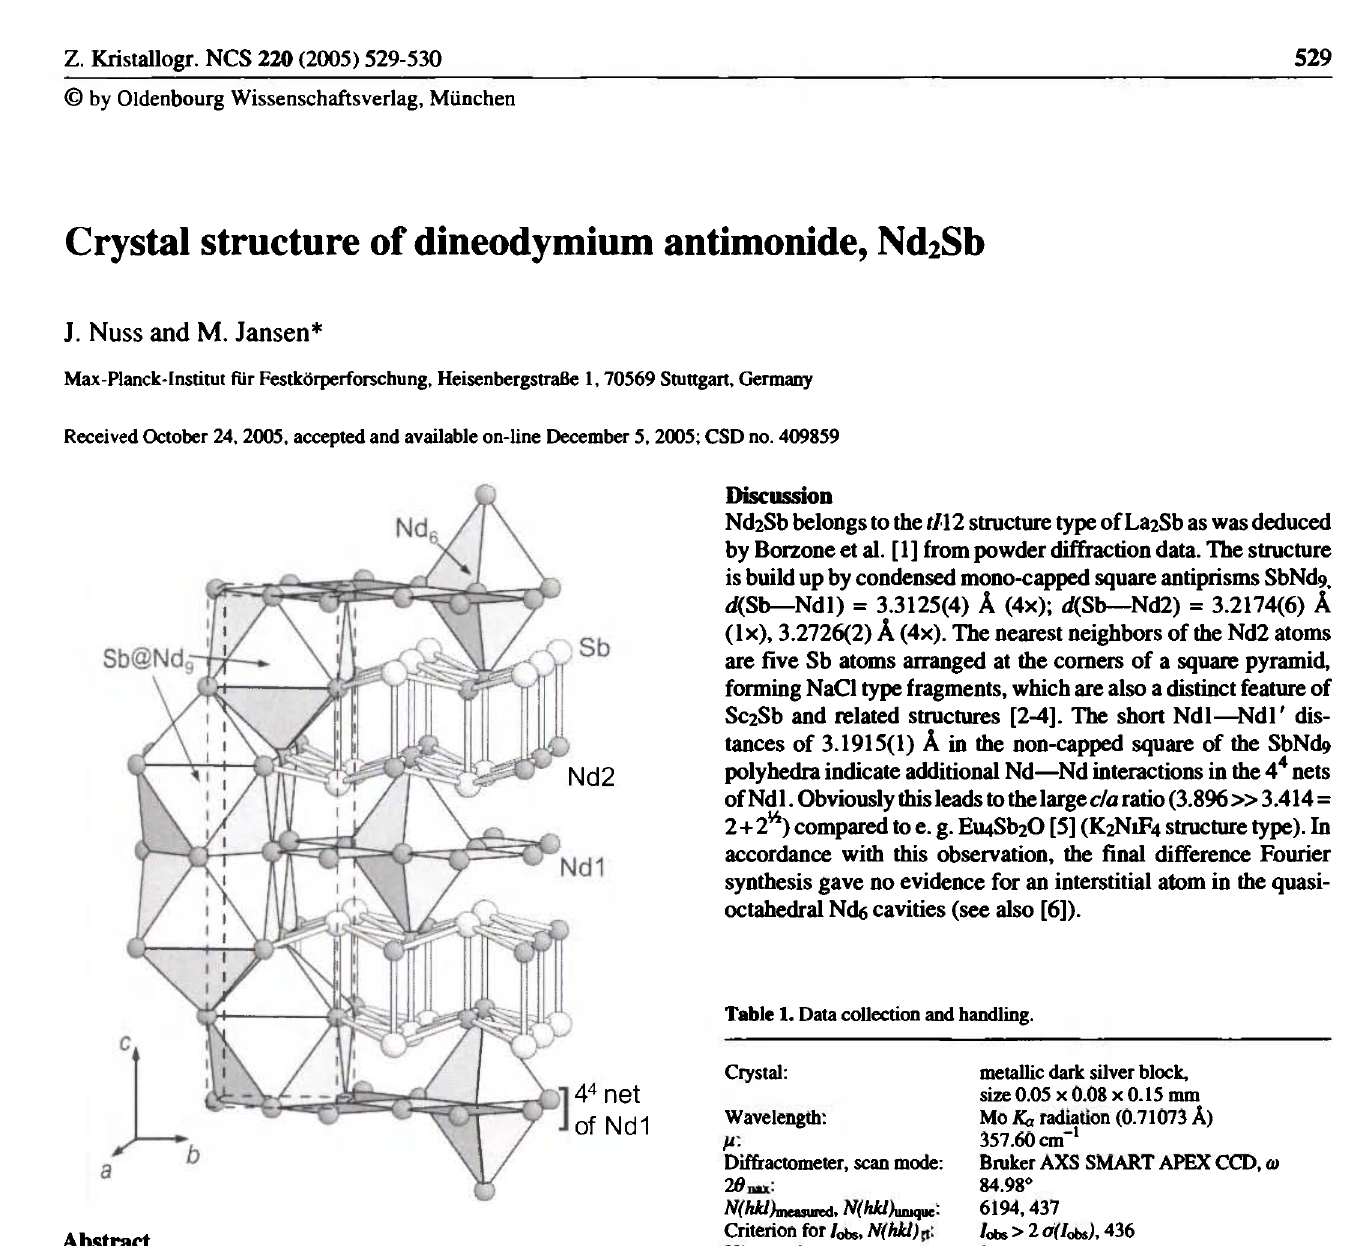
Table 2. Atomic coordinates and displacement parameters (in Ä 2